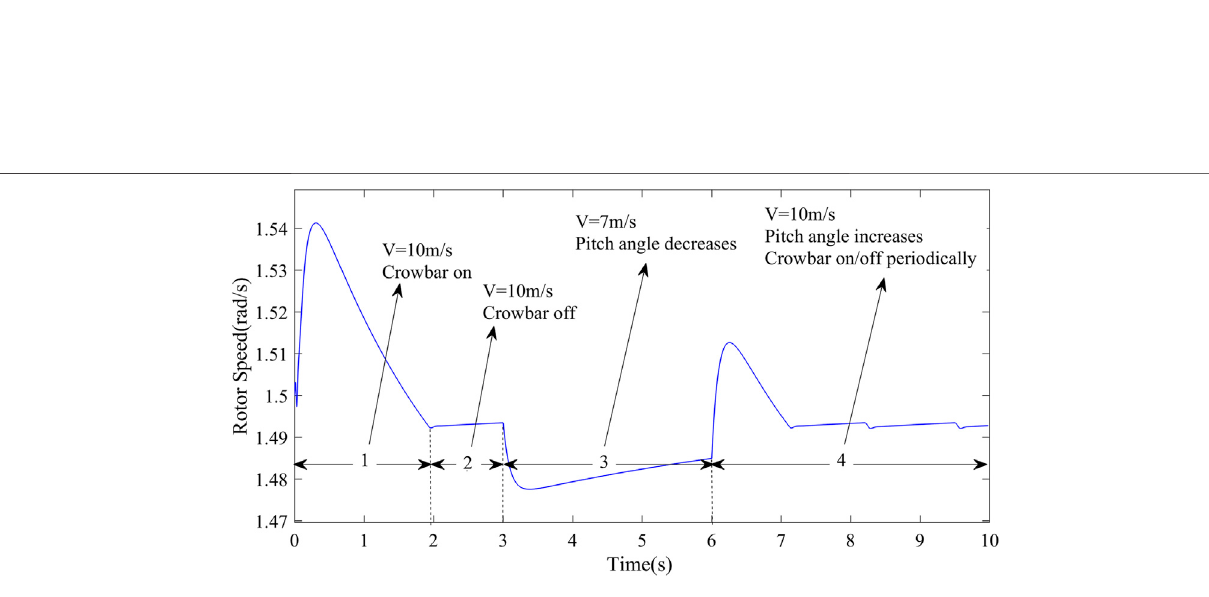
FIGURE 11 | Change of the rotor speed in case